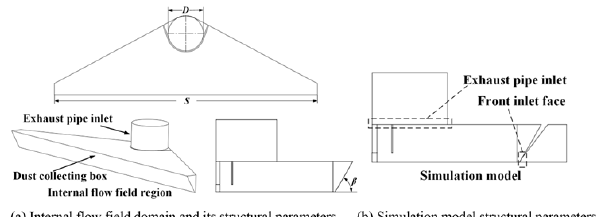
Figure 1. Simulation model and structural parameters.